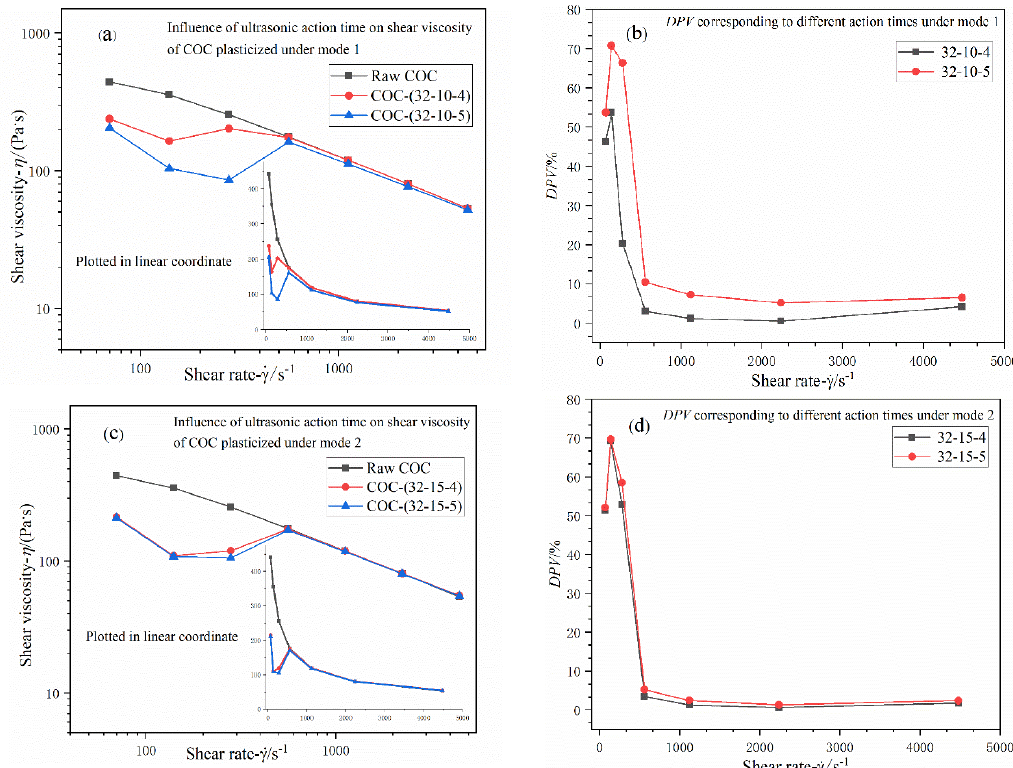
Figure 9. ( a , c ) Influence of adjusting ultrasonic action time on shear viscosity of COC plasticized under Mode 1 and Mode 2; ( b , d ) DPVs corresponding to di ff erent ultrasonic action times under two di ff erent modes. Nomenclature: ultrasonic amplitude ( µ m); plasticizing pressure (MPa); ultrasonic action time (s).